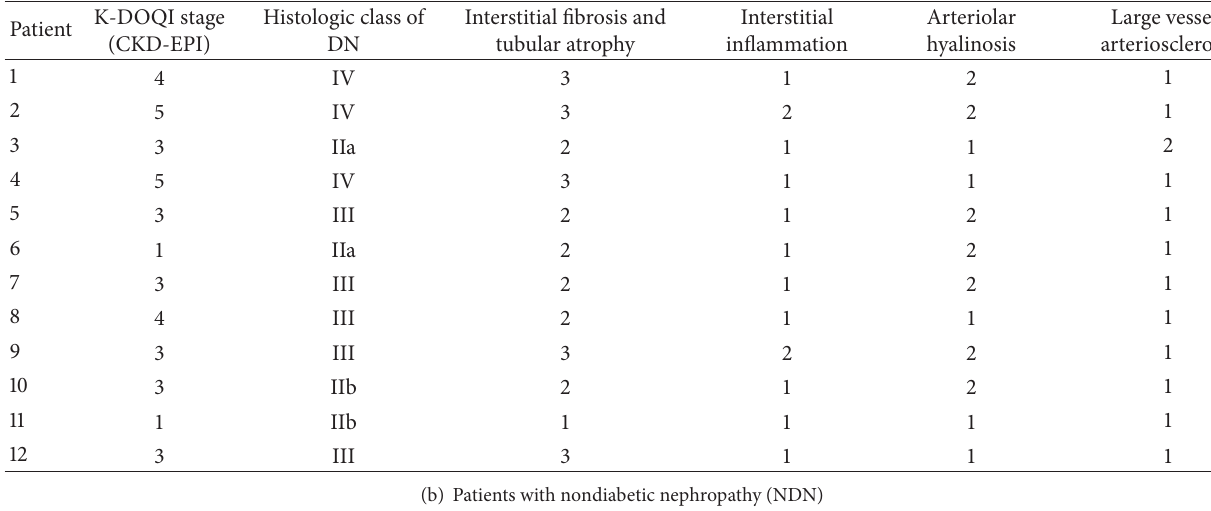
K-DOQI stage Patient